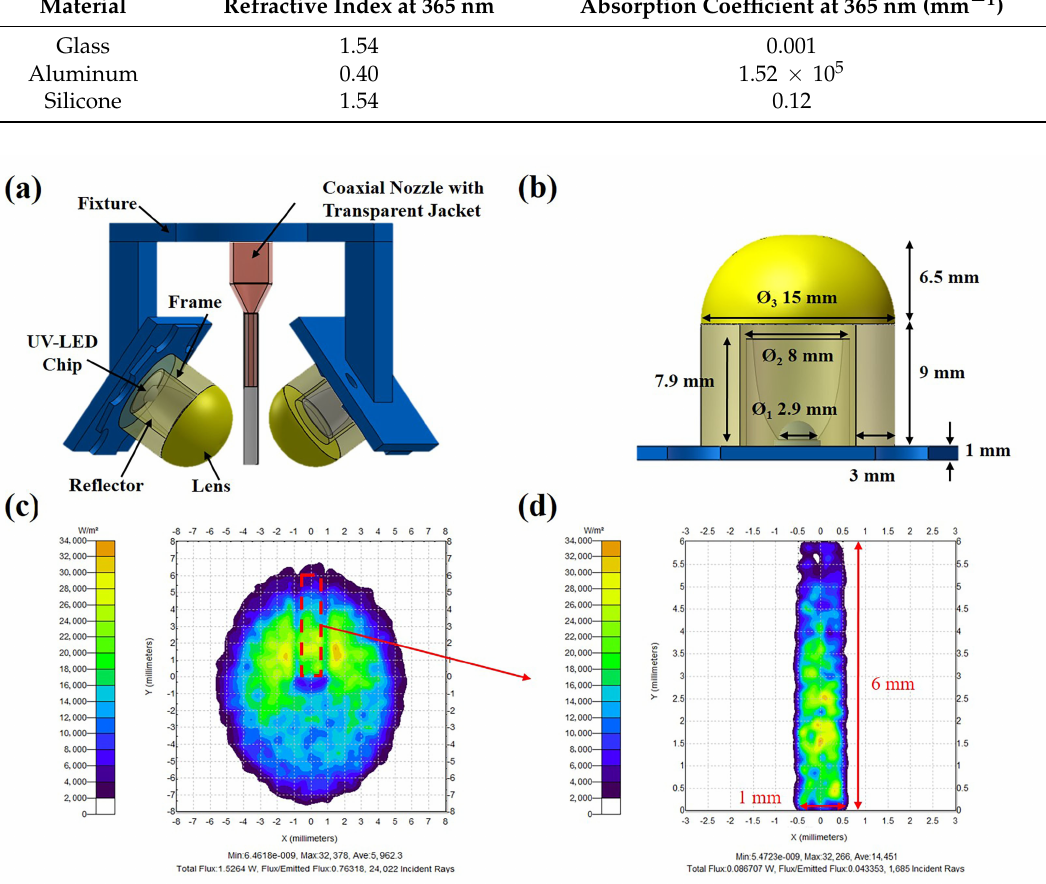
Figure 2. The converged UV-LED light source design and its simulation results: ( a ) the converged UV-LED light source attached to the coaxial nozzle; ( b ) dimension clarification of the converged UV-LED; ( c ) the total UV radiation area in an ellipse shape with a length and width of around 13 and 10 mm, respectively; and ( d ) the UV radiation for the pre-curing, which the intensity was estimated to an average of 1.45 W/cm 2 with the area of 1 × 6 mm 2